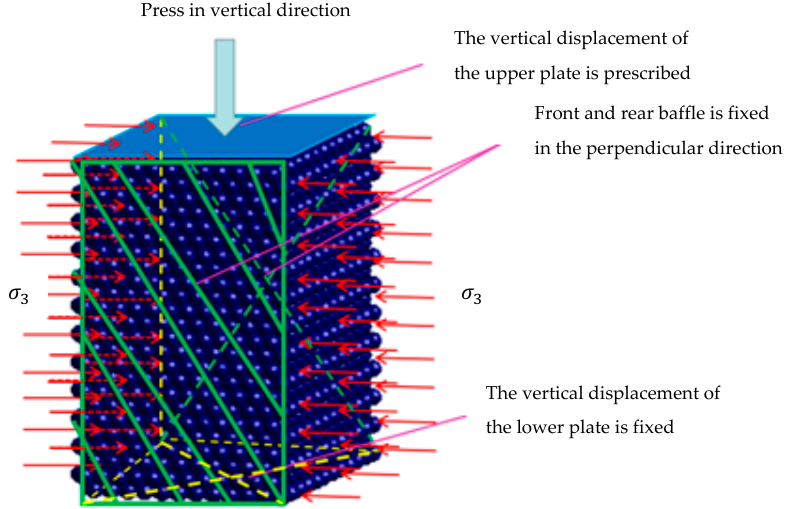
Figure 16. The discrete element numerical model for plane strain